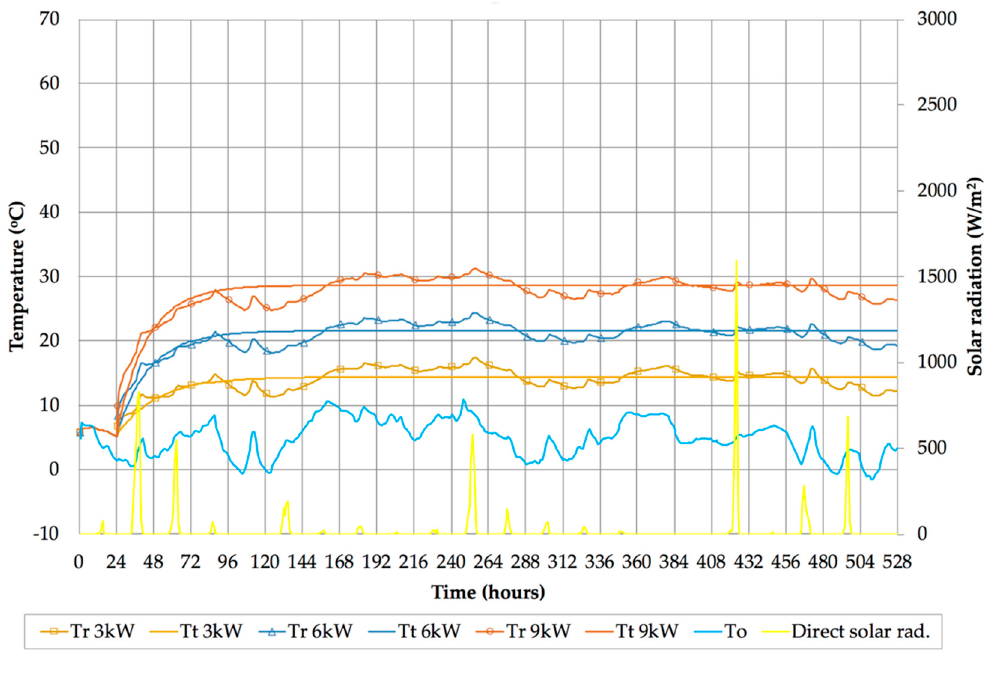
Figure 12. Dynamic heating test simulations before retrofit.